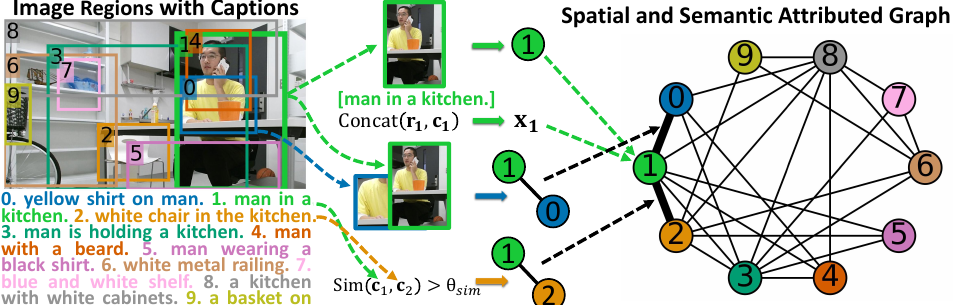
Figure 3. Example of constructing a spatial and semantic attributed graph to model regions in an image. The numbers and colors of the regions in the image and the nodes in the graph correspond to each